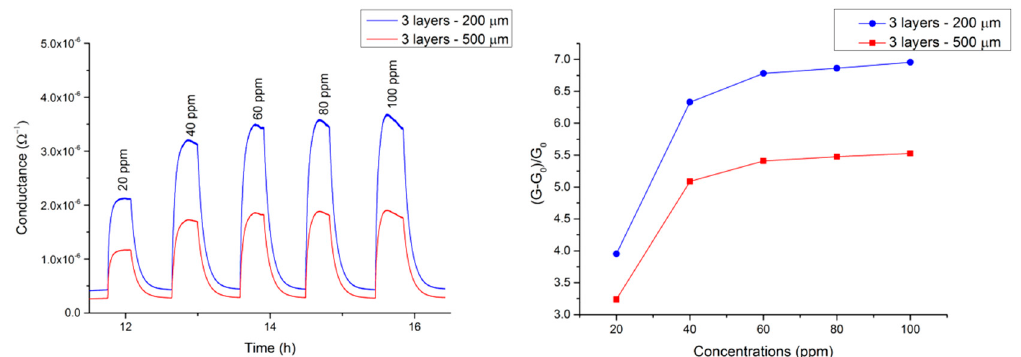
Figure 3. Response of SnO 2 thin film (three layers), with electrodes spacing of 200 μ m and 500 μ m, upon exposure to different concentrations of CO gas at 300 °C; ( a ) Conductance versus time; ( b ) relative response versus CO